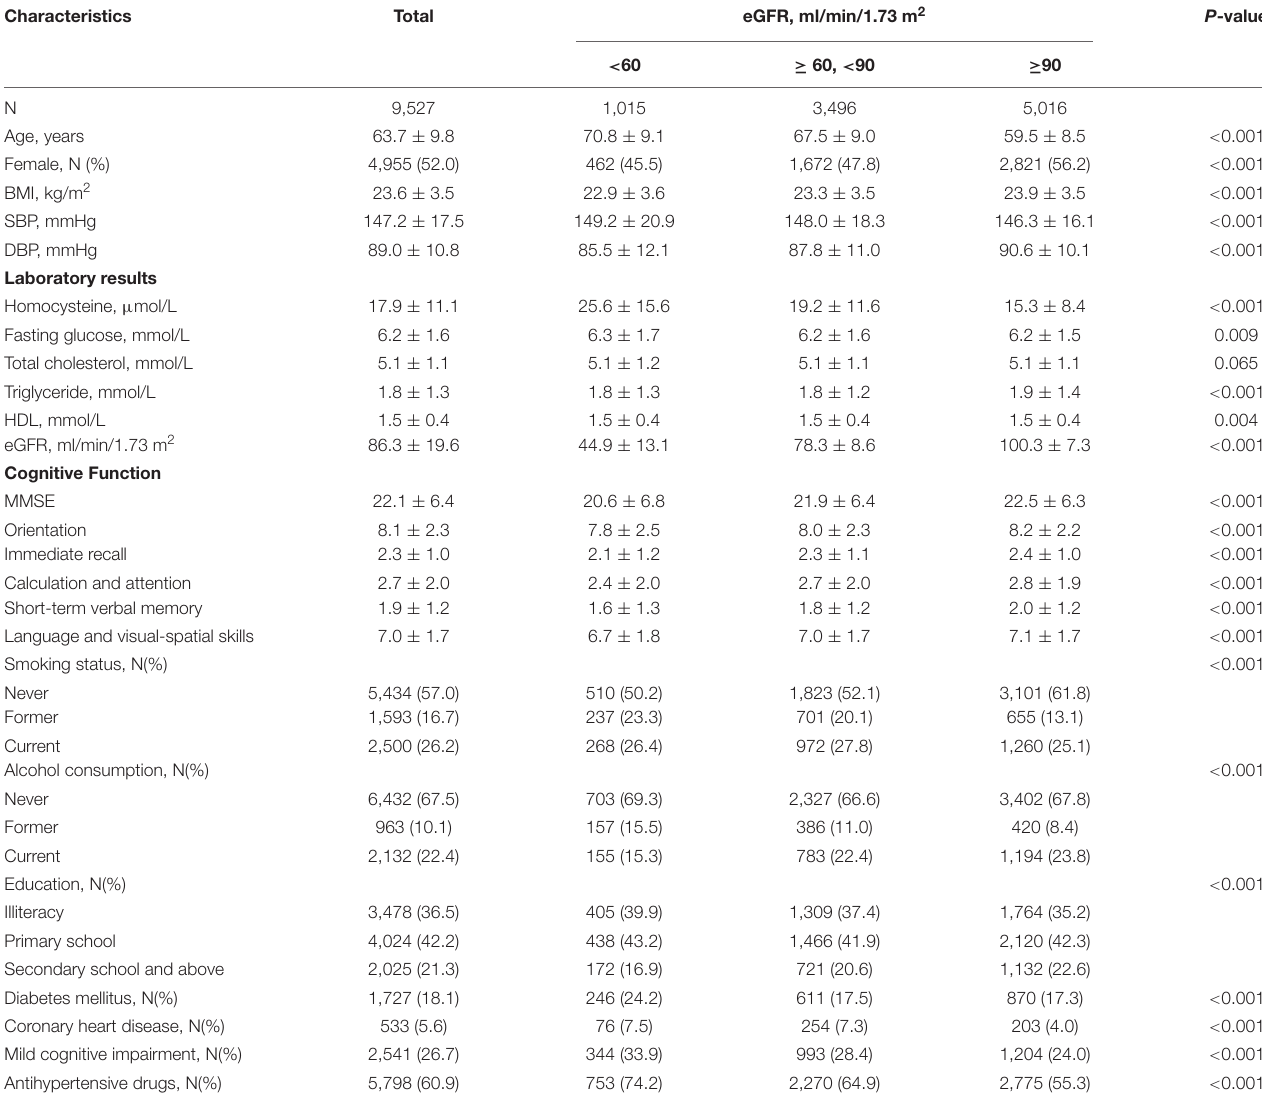
TABLE 1 | Characteristics of subjects stratified by the clinical cutoff value of eGFR.